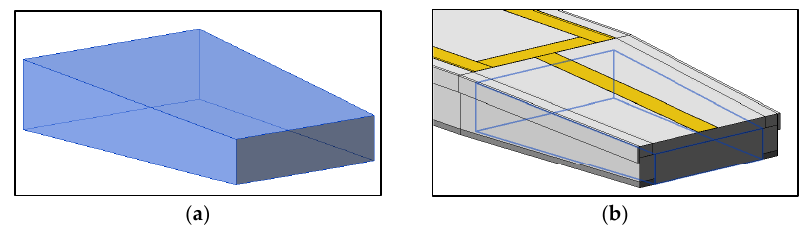
Figure 7. ( a ) Local model by Revit. ( b ) Access ramp with local model.